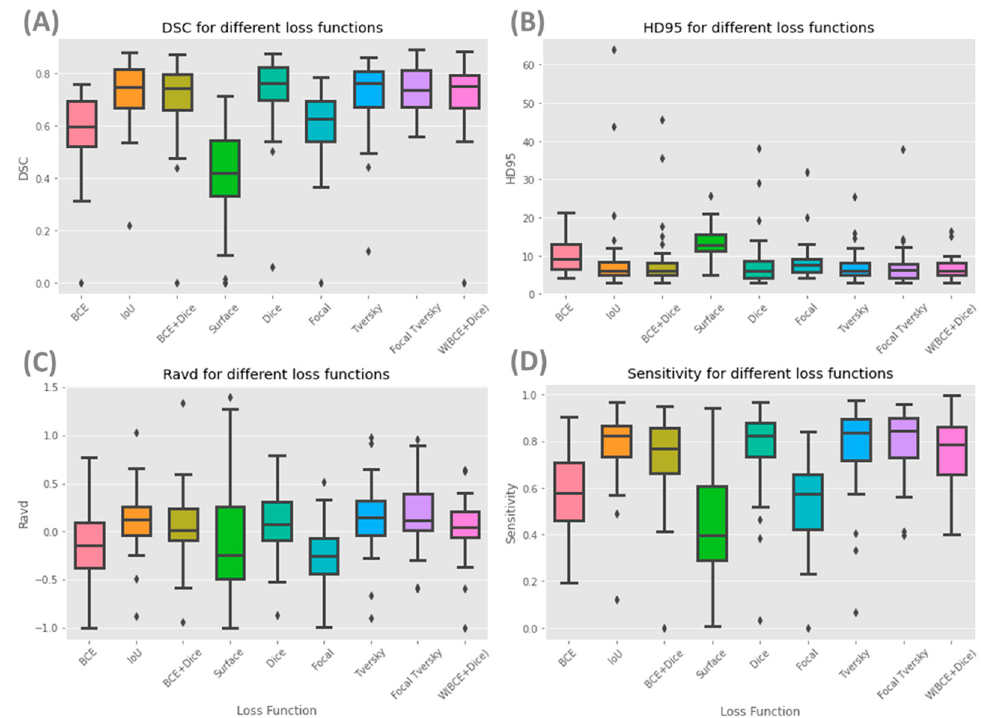
Figure 3. Each box plot ( A – D ) represents metrics DSC, HD95, Ravid and sensitivity respectively for the whole prostate on validation data from the five-fold cross-validation for models with different loss functions. DSC: Dice similarity coefficient; HD95: 95% Housdorff Distance.